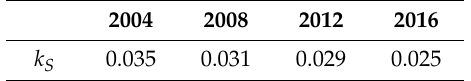
Table 2. Slope parameter k S (1/km) for urban land density.